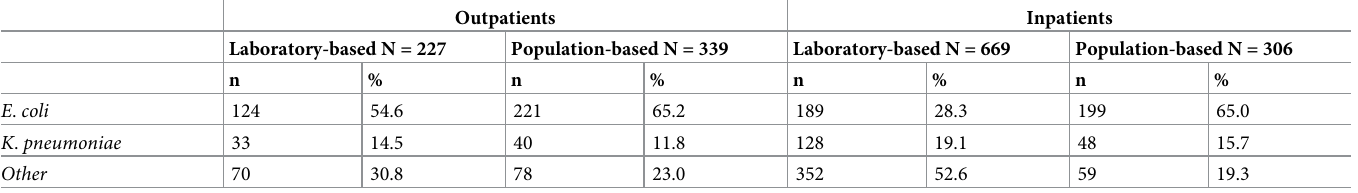
Table 1. Frequency of Escherichia coli and Klebsiella pneumoniae culture as observed during laboratory- and population-based surveillance from outpatients and inpatients.